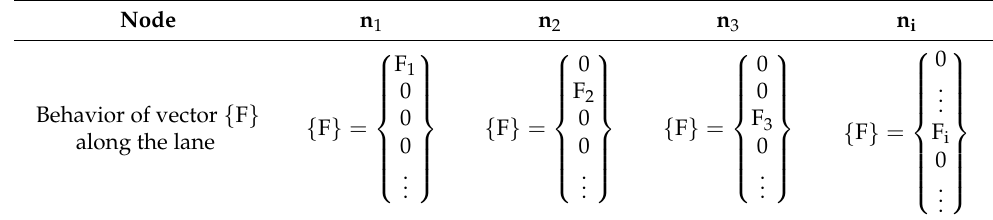
Table 1. Evolution of the force vector.